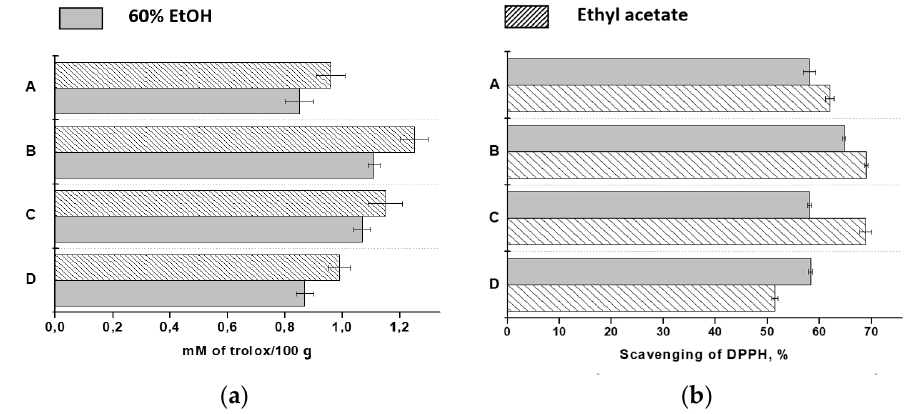
Figure 2. Antioxidant activity of lingonberry extracts evaluated by ( a ) cupric reducing antioxidant capacity (CUPRAC) and ( b ) DPPH assay.